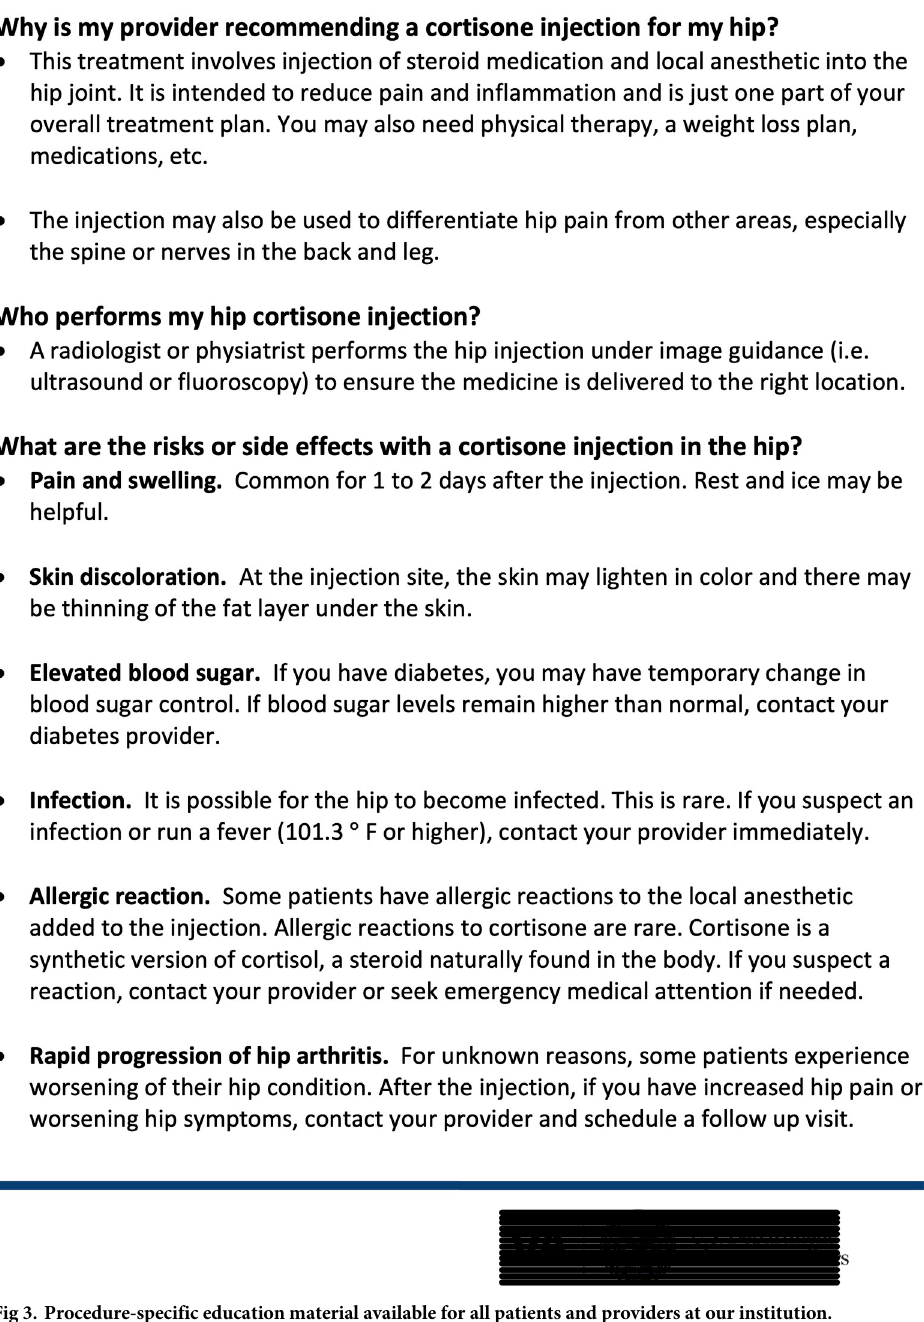
PLOS ONE | https://doi.org/10.1371/journal.pone.0259242 November2,